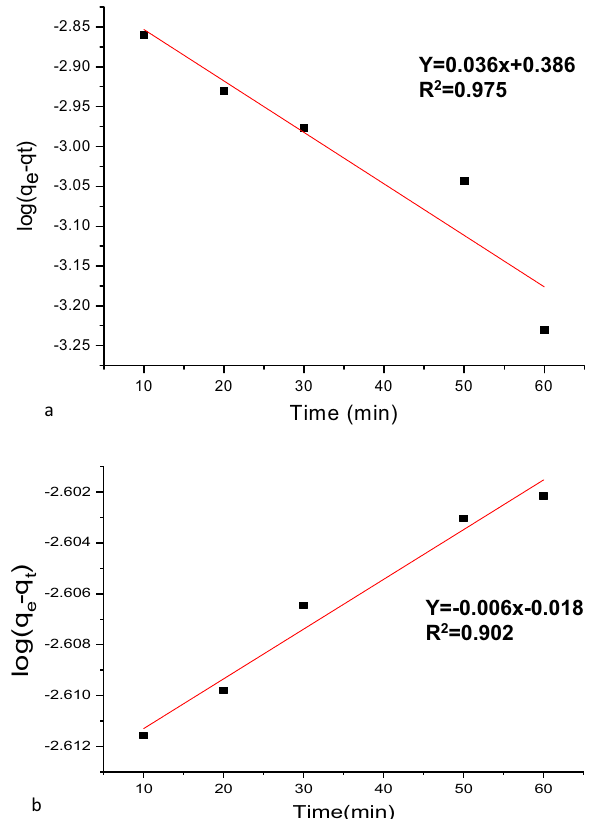
Figure 14. Pseudo-first order for the adsorption of MG onto ( a ) nano bentonite and ( b ) MgO impregnated